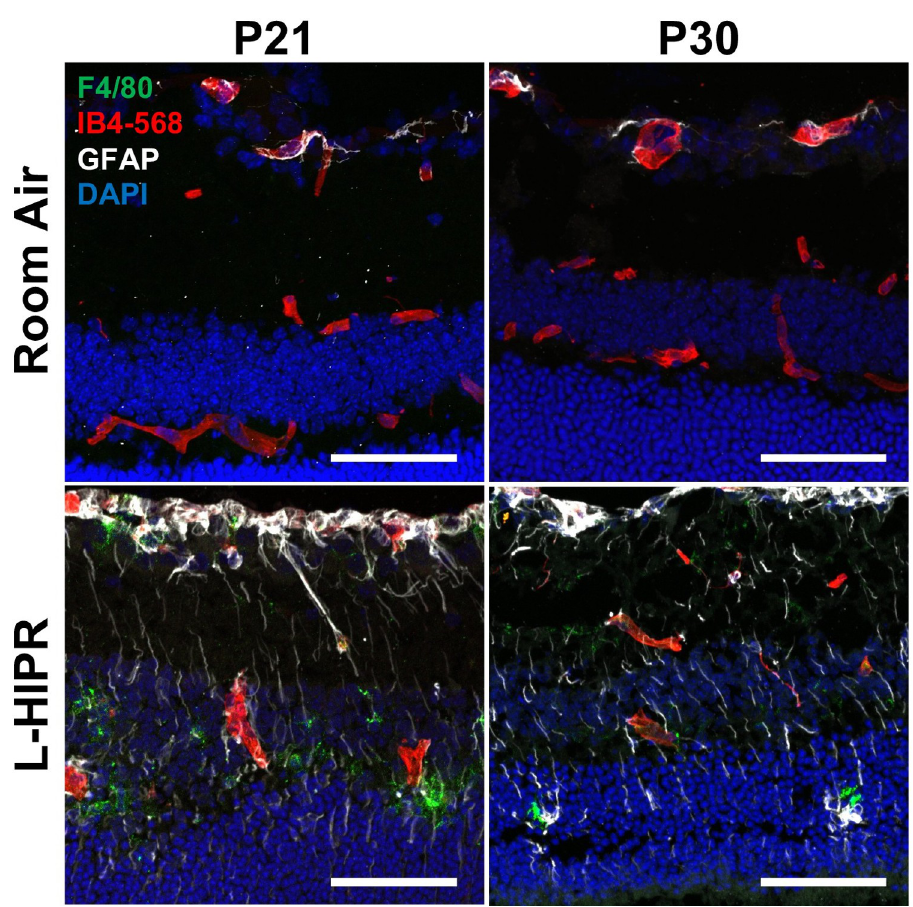
Fig 5. The L-HIPR retina is inflamed. (A) Immunolabeled cryosections at P21 and P30 of room air and L-HIPR tissue. Macrophages were labeled with anti-F4/80 (green), blood vessels with IB4 (red), astrocytes/activated Muller cells with GFAP (white), and nuclei with DAPI (blue). The room air tissues show GFAP + astrocytes in the ganglion cell layer, however, the Muller cells become GFAP + indicating an activated state in L-HIPR at both P21 and P30. F4/80 + macrophages can be seen in the inner and outer nuclear layers in the L-HIPR sample. Scale bars equal 50 μ